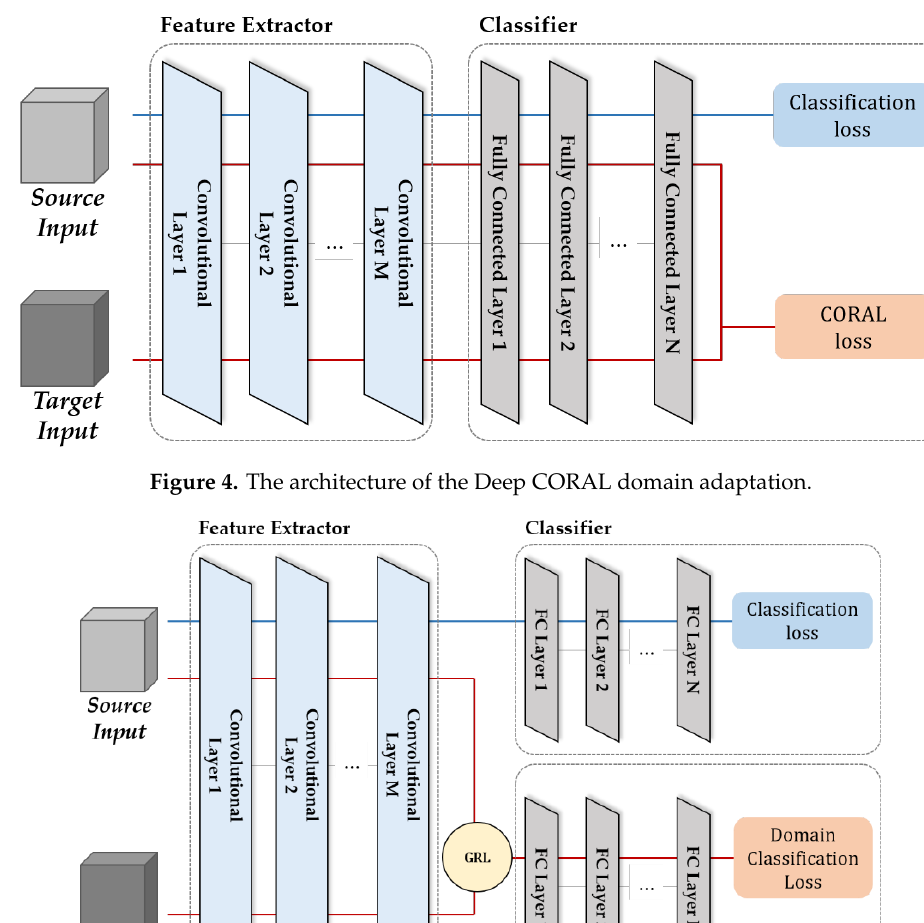
Figure 6. The architecture of Decision-boundary Iterative Refinement Training with a Teacher (DIRT- T) domain adaptation. Recently, self-supervision provides a new direction for domain adaptation [34]. It proves that the self-supervision method with auxiliary tasks helps the target adaptation performance. It argues that well-designed auxiliary self-supervision tasks can help to capture the structural information of